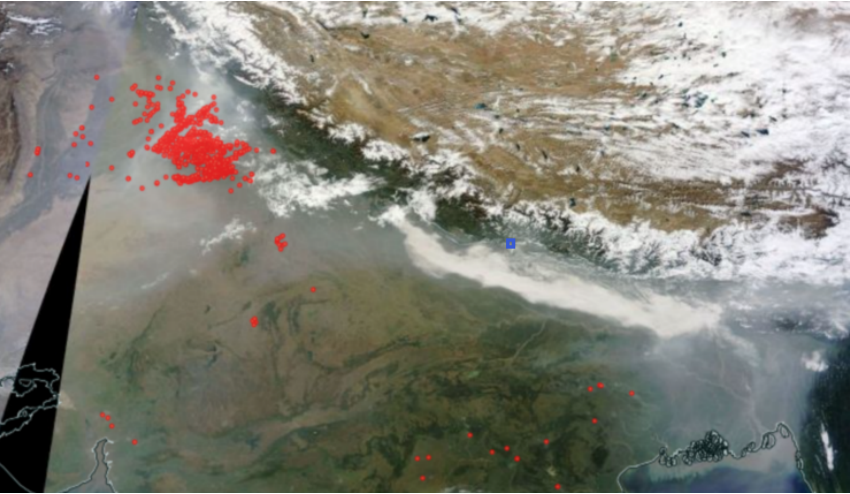
Figure 10. MODIS image from 1 November 2013 showing the smoke plume over the IGP and active fire spots (https://worldview.earthdata. nasa.gov/). The blue square represents the location of